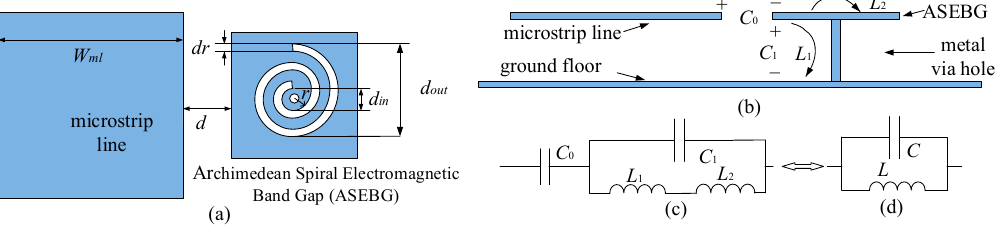
Figure 2. ( a ) The top view of ASEBG structure; ( b ) the side view of ASEBG structure; ( c ) the equivalent circuit diagram of ASEBG structure; ( d ) the equivalent circuit for calculating resonance frequency of ASEBG structure.